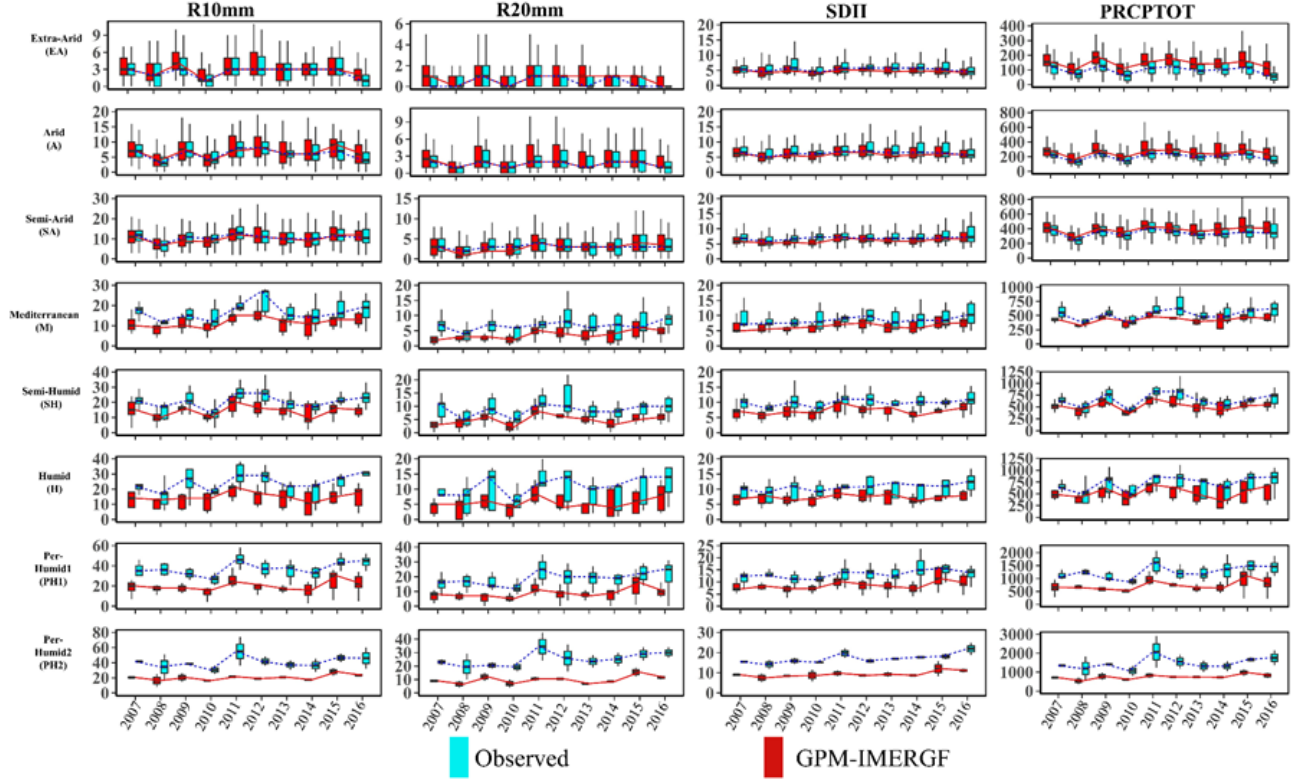
Figure 7. Temporal behavior of GPM-IMERGF in capturing maximum precipitation indices beside corresponding indices based on synoptic stations throughout 2007 to 2016.